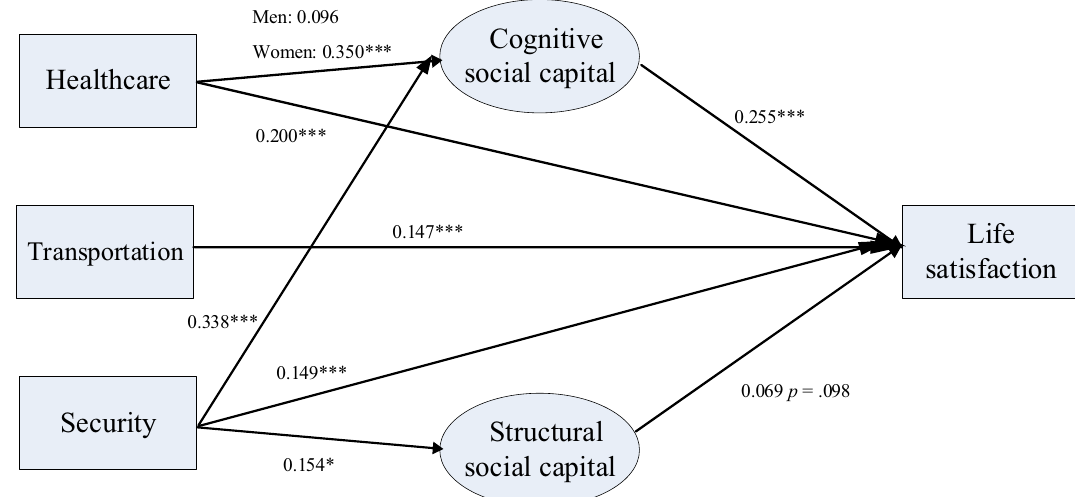
Figure 1. The Structural Model of Perceived Neighborhood Environment, Social Capital and Life Satisfaction: The Moderator Role of Gender. Notes: Only standardized coefficients are reported. * p < .05 (two-tailed); *** p < .001 (two-tailed); The covariates were controlled in the